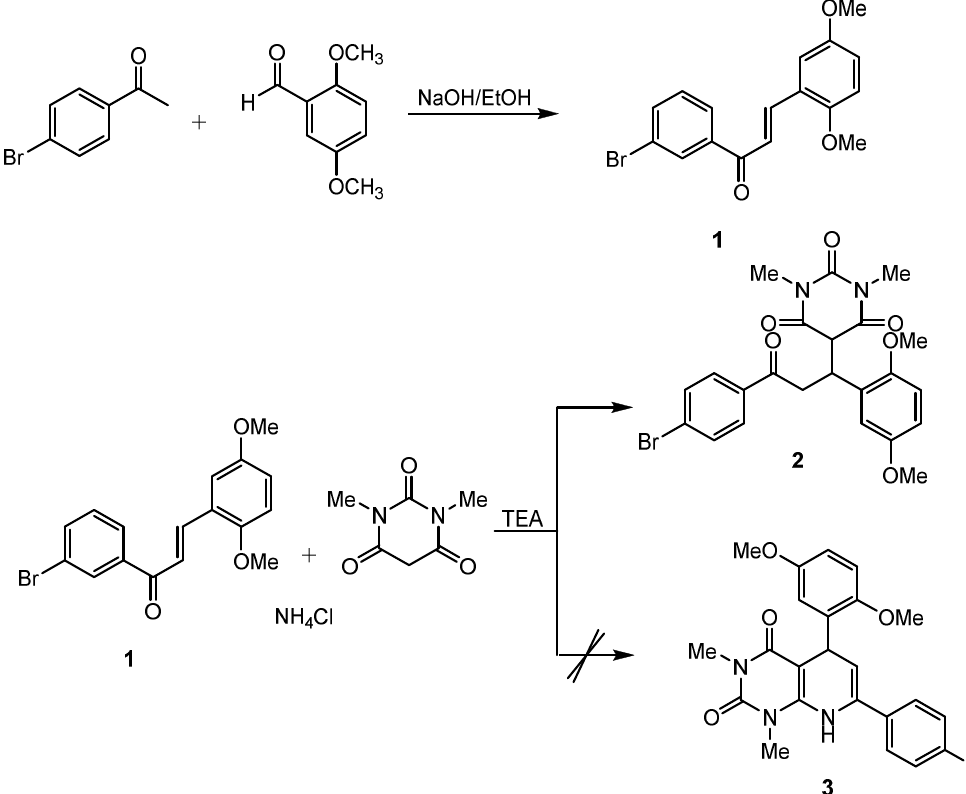
Figure 1. The reaction process for the synthesis of the title compound.